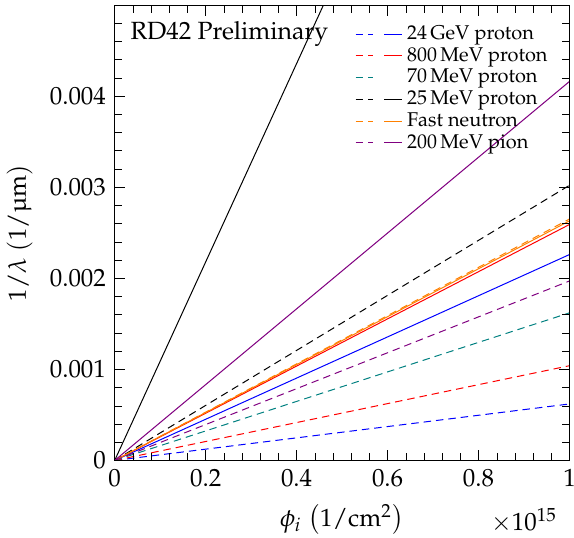
Figure 17. The 1/ λ for CVD diamond and silicon for proton, neutron and pion irradiations at an electric field of 2V/µm. The charge collection was measured at room temperature. The dashed lines are diamond results from this work and those in [4] for irradiations at 24GeV protons (blue), 800MeV protons (red), 70MeV protons (green), fast neutrons (orange), and 200MeV pions (purple), and the solid lines are the silicon damage data from RD50 [28] for proton (blue and red), neutron (orange), and pion (purple) irradiations. The curves for irradiations with 25MeV protons were taken from